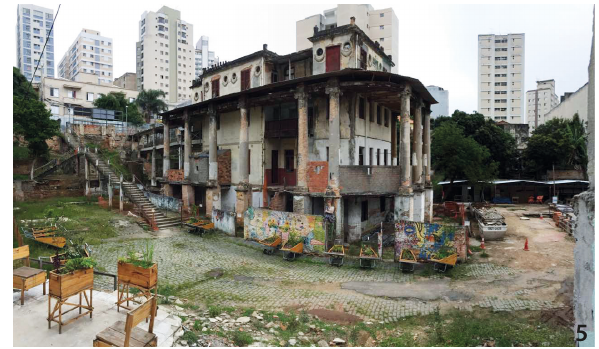
Figure 5 Vila Itororo, Sao Paulo. (Source: the author,